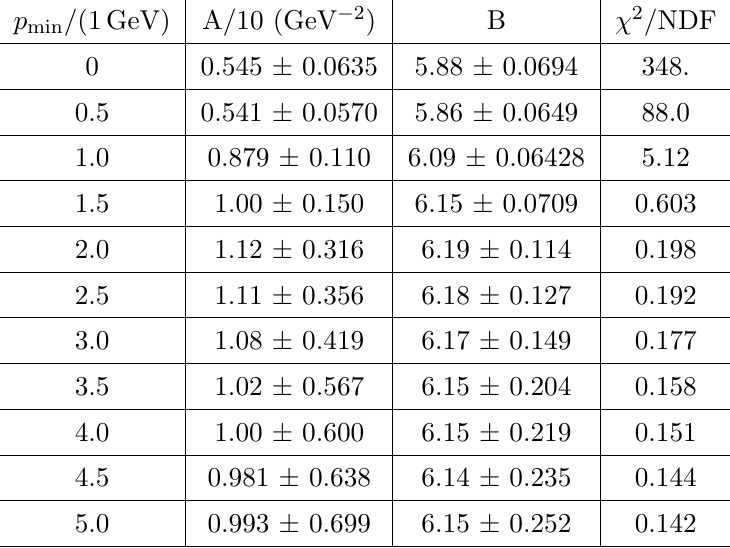
Table 8. Fitted values of parameters in eq. (E.2) for the ALICE dataset at p s = 5 : 02 TeV in the